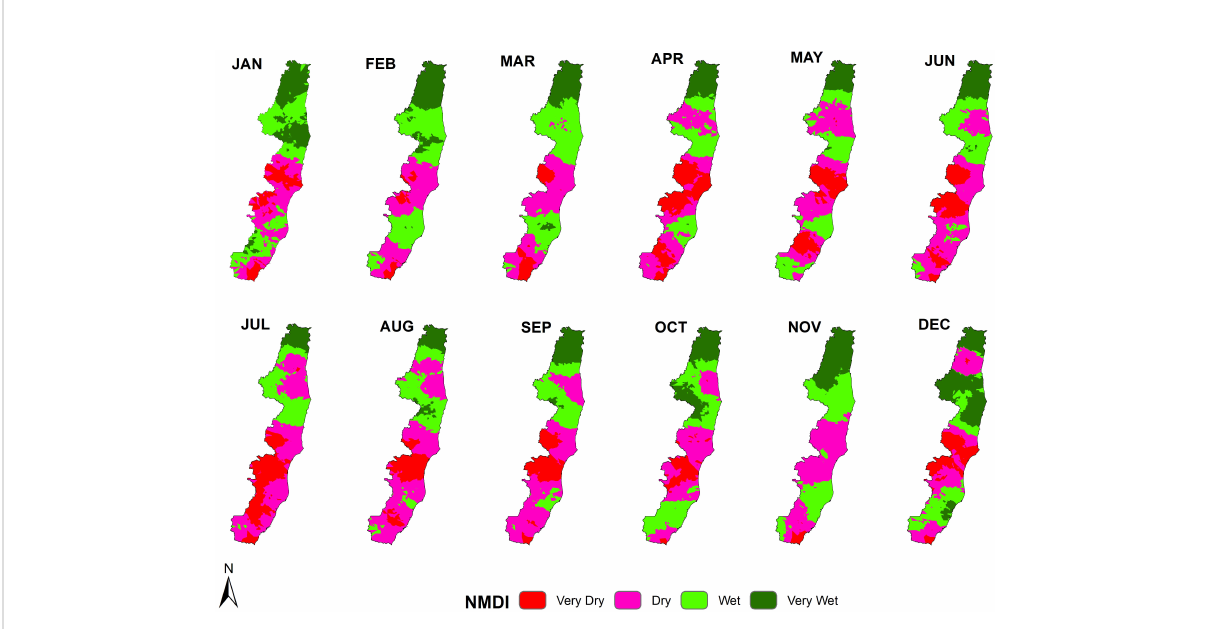
FIGURE 3 NMDI spatial analysis for the Pettit test (for the year 2014) in the Central Atlantic Forest